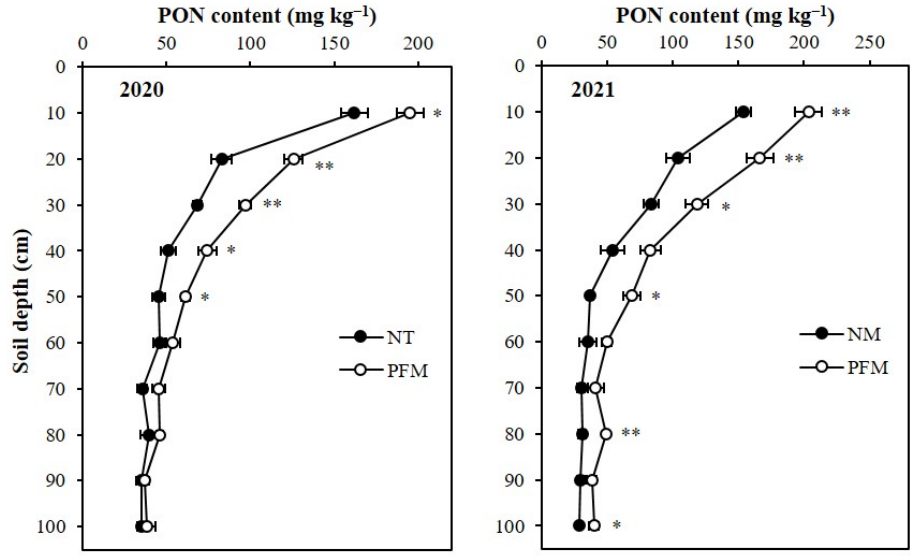
Figure 2. Effects of plastic film mulching and no-mulching treatments on the depth distribution of soil particulate organic N (PON) in the soil profile. ** Significant differences between treatments at p < 0.01, * significant differences between treatments at p < 0.05. 2020, soil sampling at final harvest in 2020;